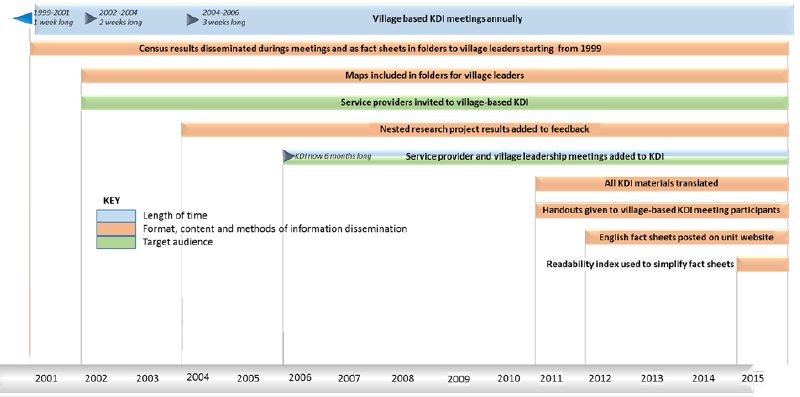
Figure 2: Changes in